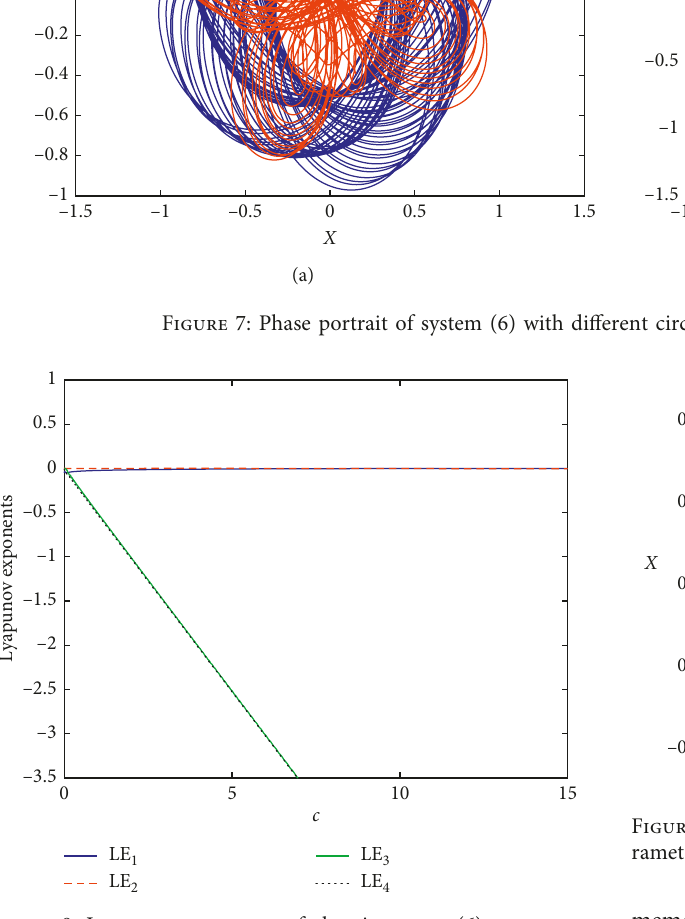
Figure 8: Lyapunov exponents of chaotic system (6) versus pa- rameter c .